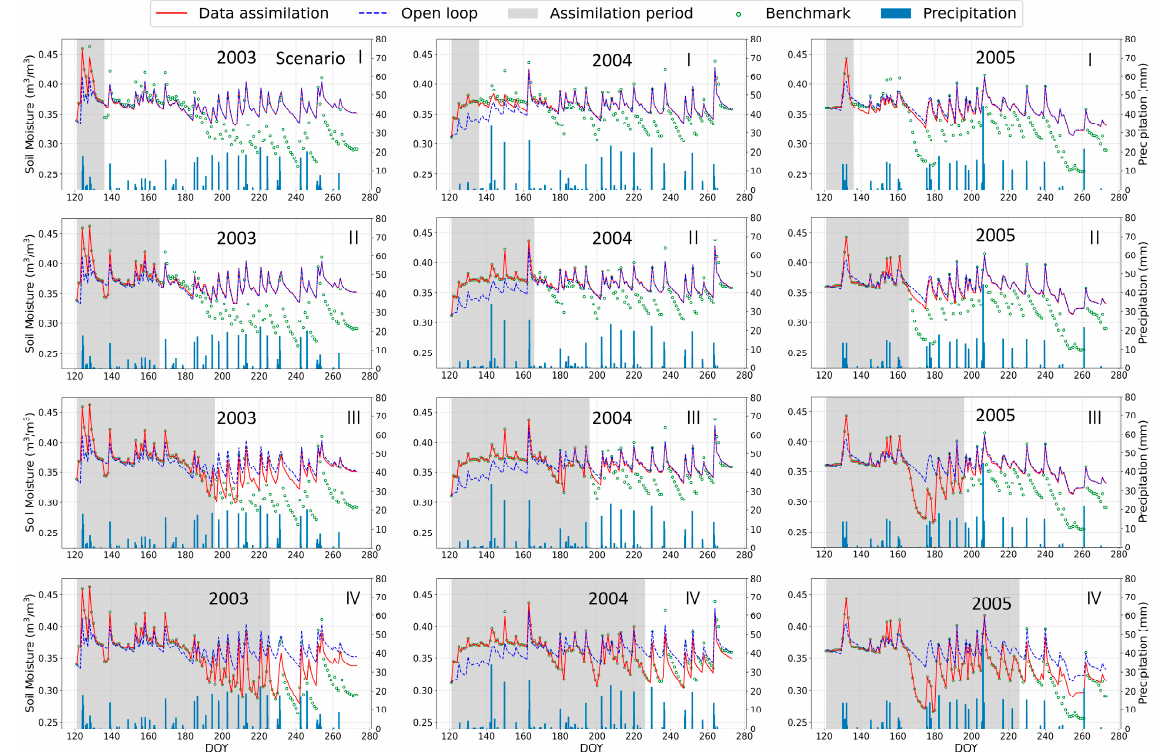
Figure 3. Soil moisture simulation and prediction from OL and MLDAS in 2003–2005. Results of four assimilation scenarios with different assimilation periods are given. Columns represent different assimilation scenarios in each year. The red solid line in each subplot represents MLDAS simulation and prediction; the blue dashed line in each subplot represents OL simulation; the green hollow scatters represent SM benchmarks; the blue bars are precipitation; and the shaded regions are the assimilation period, which starts from 1 May and lasts for 15 days, 45 days, 75 days, and 105 days for scenario Ⅰ , II , Ⅲ , and Ⅳ , respectively.